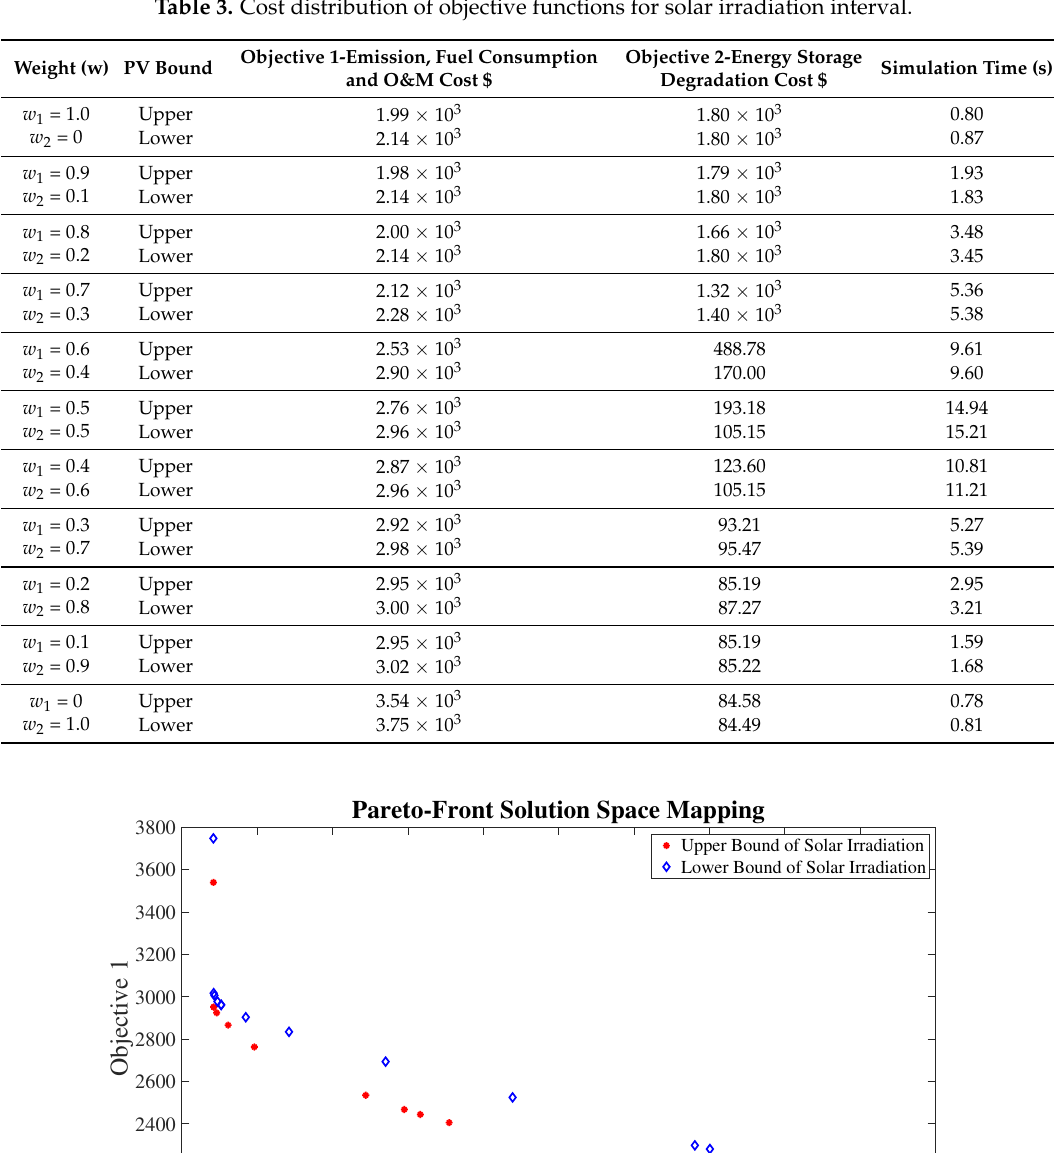
Table 3. Cost distribution of objective functions for solar irradiation interval.